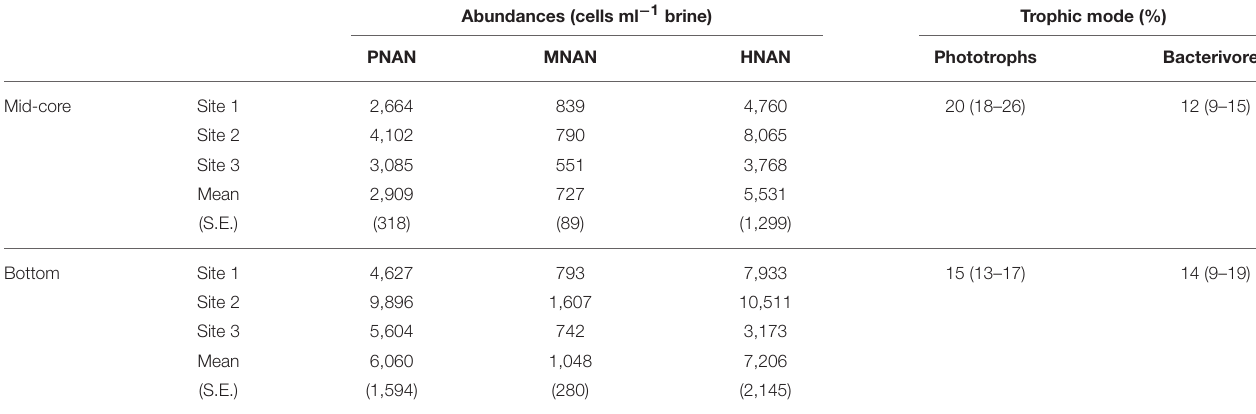
TABLE 3 | Abundances of phototrophic (PNAN), mixotrophic (MNAN) and heterotrophic (HNAN) nanoflagellates in sea ice brine channels (station means of three replicate cores) from the middle and bottom of cores (see Methods) and the relative percentage of mixotrophs as total phototrophs and total bacterivores based on all